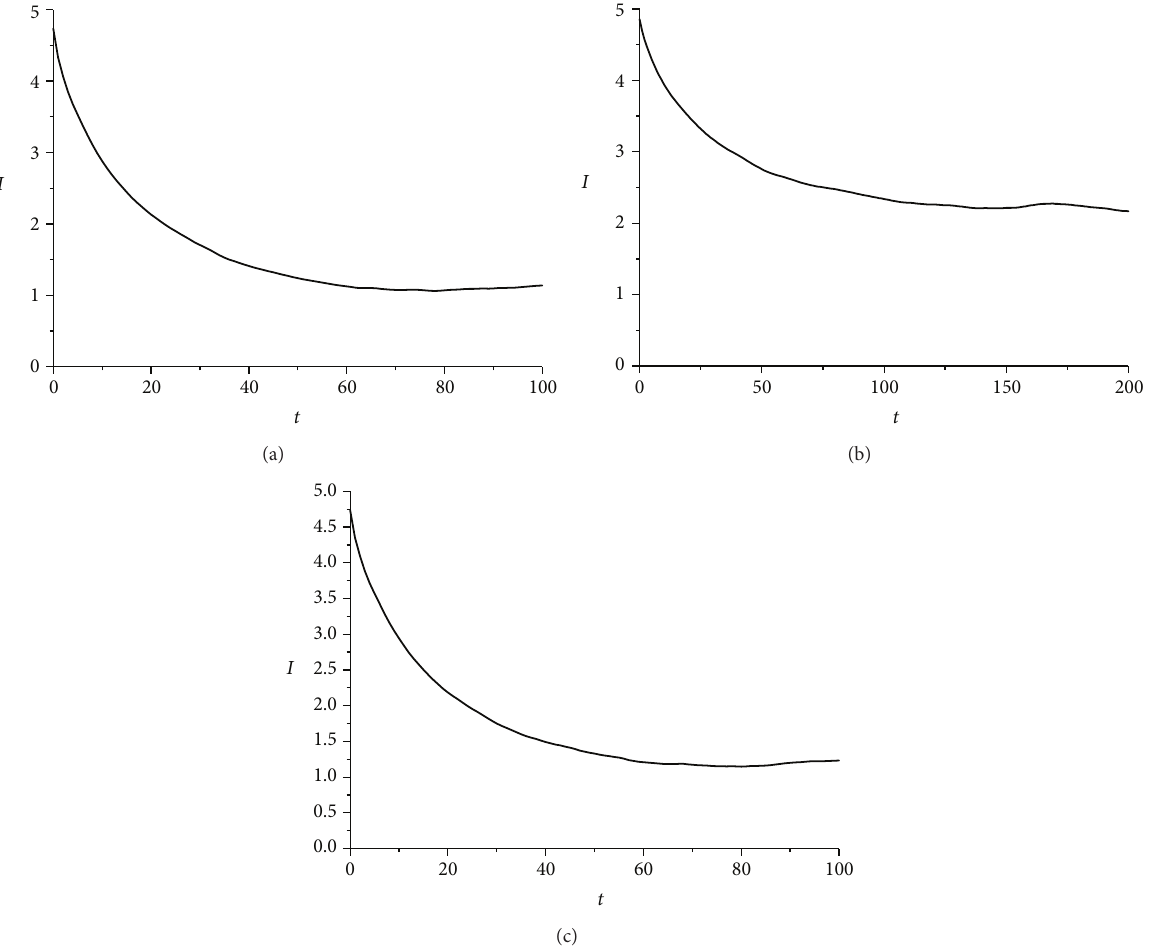
Figure 6: Average mutual information 𝐼(𝜏) versus 𝜏 time delay for roll angle 𝛼(𝑡) time-series, in the case of (a) wax, 𝜏 = 63 , 𝑊 = 78 , (b) gypsum, 𝜏 = 140 , 𝑊 = 200 , and (c) lead-solder, 𝜏 = 65 , 𝑊 = 80 . 𝜏 is the first minimum and 𝑊 is the absolute minimum and this value is regarded as the Theiler